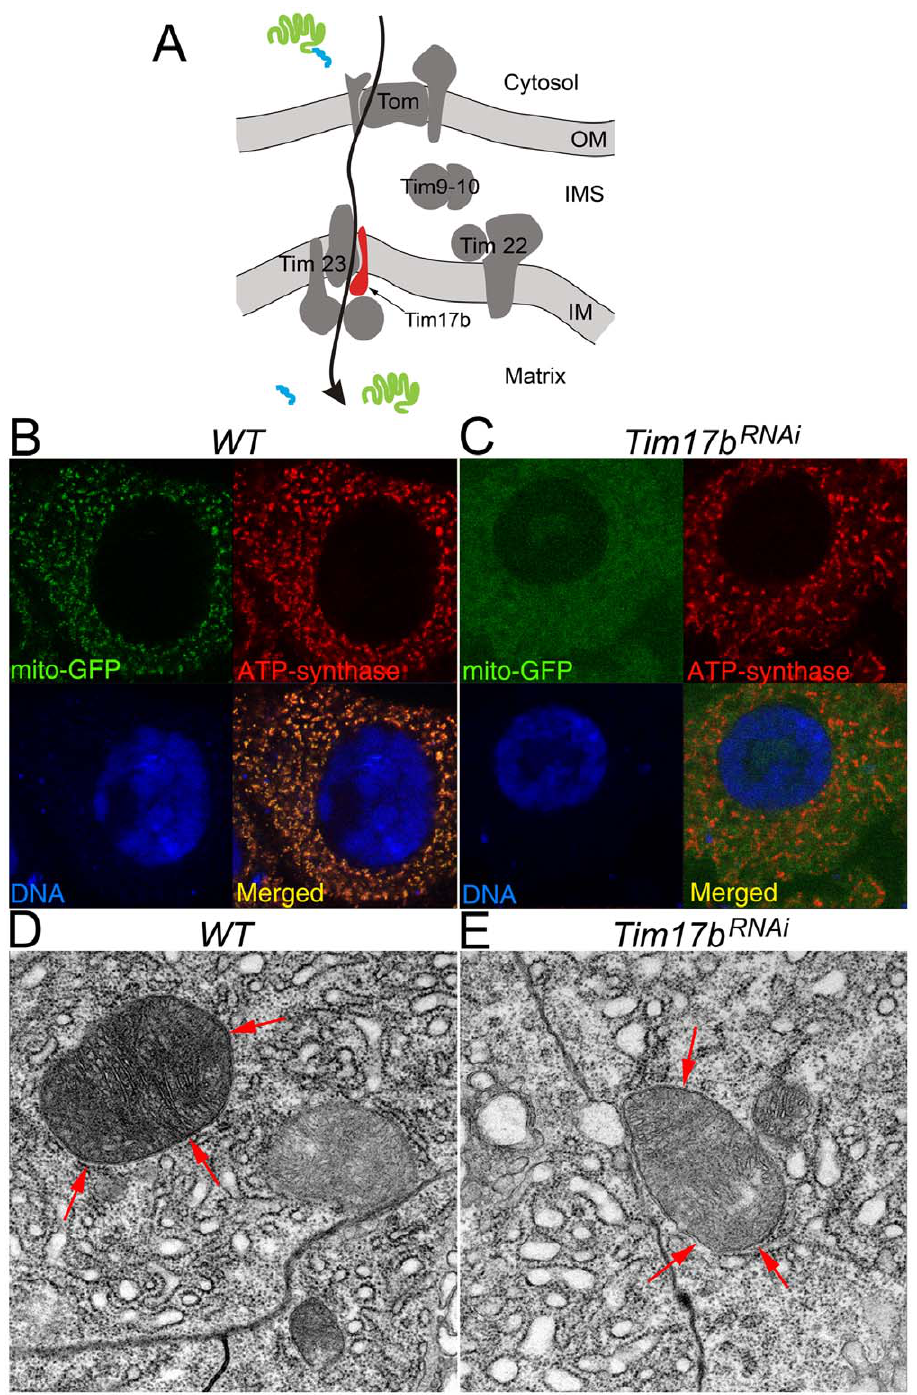
Figure 4. Elimination of Tim17b function by RNAi expression disrupts protein delivery to mitochondrial matrix. A. Model of organization and function of mitochondrial translocase complexes TOM, TIM9-10, TIM23 and TIM22. Arrow shows pathway of protein with cleavable N-terminal signal translocation through TOM-TIM23 into matrix. Position of Tim17b protein (red) in TIM23 complex is shown. OM – outer membrane; IMS – intermembrane space; IM – inner membrane. Green – protein of mitochondrial matrix. Blue – cleavable N-terminal signal peptide. B–C. Tim17 is required for mito-GFP delivery to mitochondria. The dissected larval mid-intestine expressing mito-GFP (green) ( B ) or co-expressing mito-GFP (green) with Tim17b RNAi ( C ) were stained with anti-ATP-synthase antibody (red) and TOTO3 DNA binding dye (blue). Displacement of mito-GFP from mitochondria is clearly seen in Tim17b RNAi –expressing tissues. D – E. TEM analysis of tissues shown in B – C panels demonstrates that mitochondrial structure has still not been compromised by the time mito-GPF delivery to mitochondria is disrupted. Red arrows indicate mitochondria.